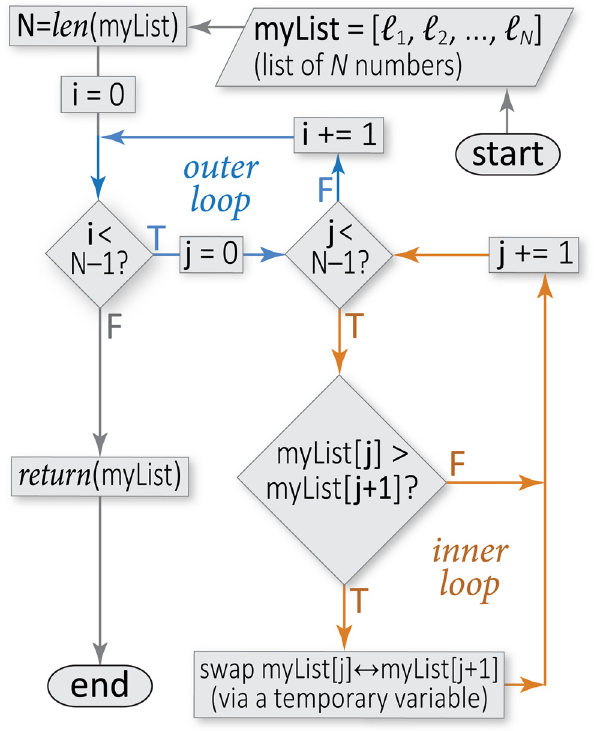
Fig 3. Sample flowchart for a sorting algorithm. This flowchart illustrates the conditional constructs, loops, and other elements of control flow that comprise an algorithm for sorting, from smallest to largest, an arbitrary list of numbers (the algorithm is known as “ bubble sort ” ). In this type of diagram, arrows symbolize the flow of logic (control flow), rounded rectangles mark the start and end points, slanted parallelograms indicate I/O (e.g., a user-provided list), rectangles indicate specific subroutines or procedures (blocks of statements), and diamonds denote conditional constructs (branch points). Note that this sorting algorithm involves a pair of nested loops over the list size (blue and orange), meaning that the calculation cost will go as the square of the input size (here, an N -element list); this cost can be halved by adjusting the inner loop conditional to be “ j < N (cid:4) i (cid:4) 1 ” , as the largest i elements will have already reached their fi nal